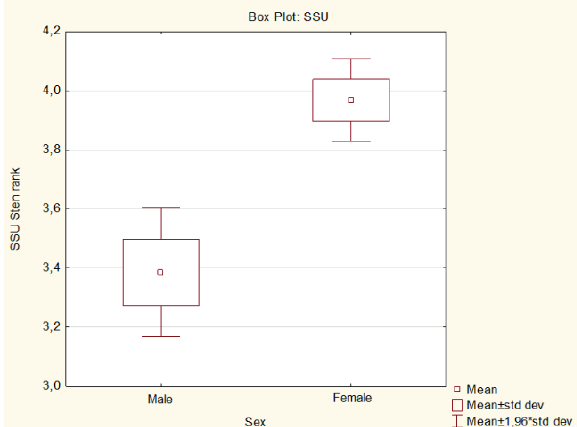
Figure 3. The differences of avoidance-oriented styles of coping rank between sexes. Box Plot.